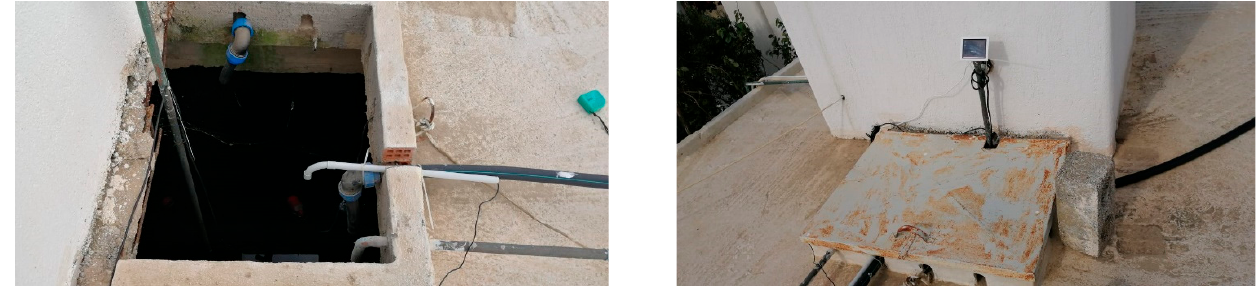
Figure 12. Measurement of the water level in a roof tank.